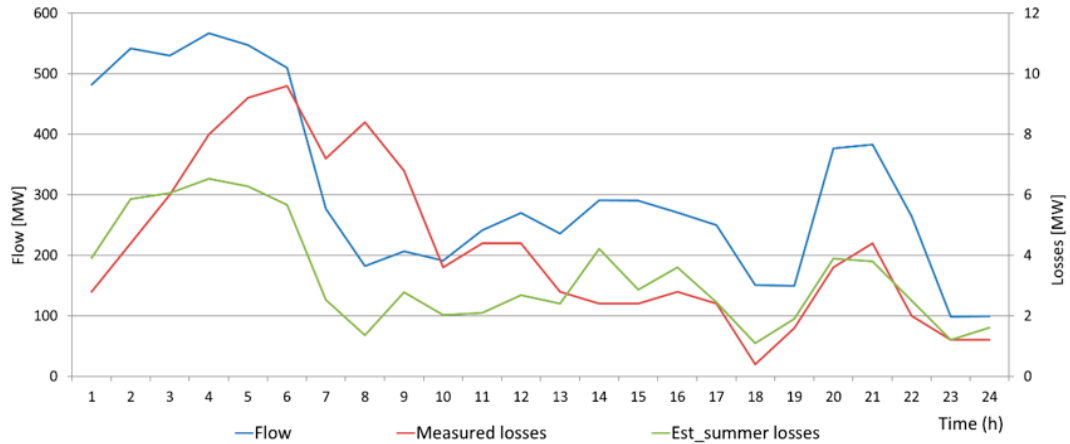
Figure 18. Losses on a 400 kV transmission grid showing the occurrence of corona losses for a daily period for 20 May 2020.